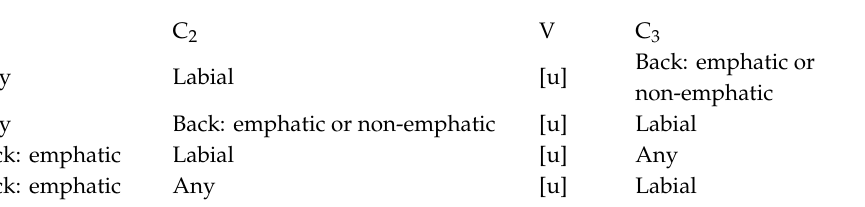
Figure 8. The change from /Tibag/ to [Tubag] (Youssef 2015, p. 82).